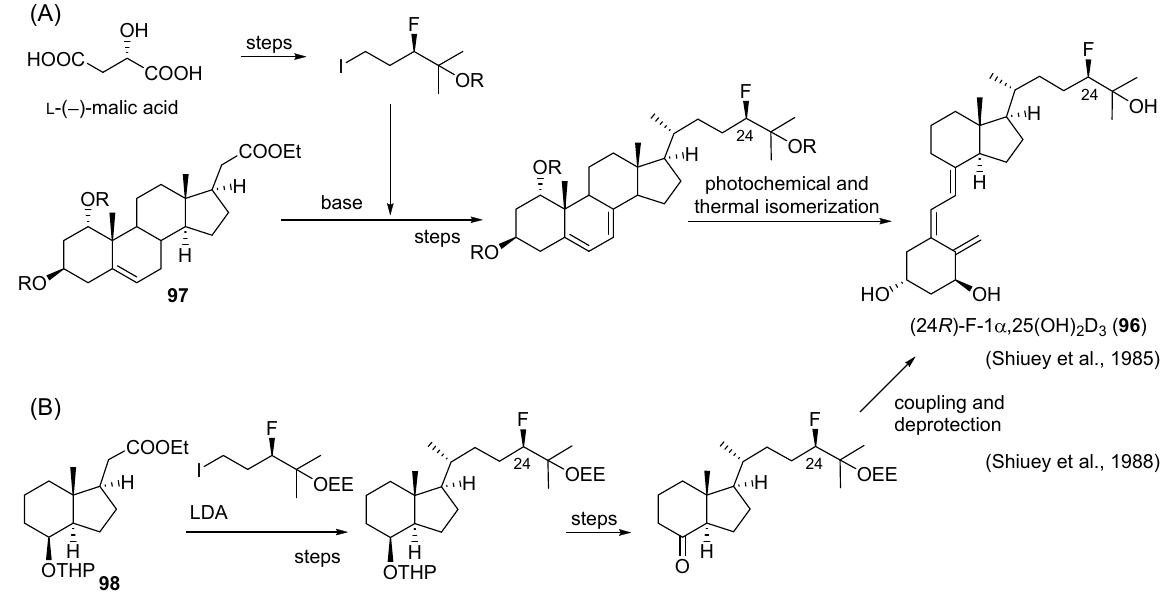
Scheme 33. (24 R )-Fluoro-1 α ,25(OH) 2 D 3 ( 96 ) was synthesized by Uskokovi ć et al. through a linear synthetic route using 97 and optically active L -( ‒ )-malic acid as a chiral synthon ( A ) and an alternative convergent route starting from a CD-ring part, 98 ( B